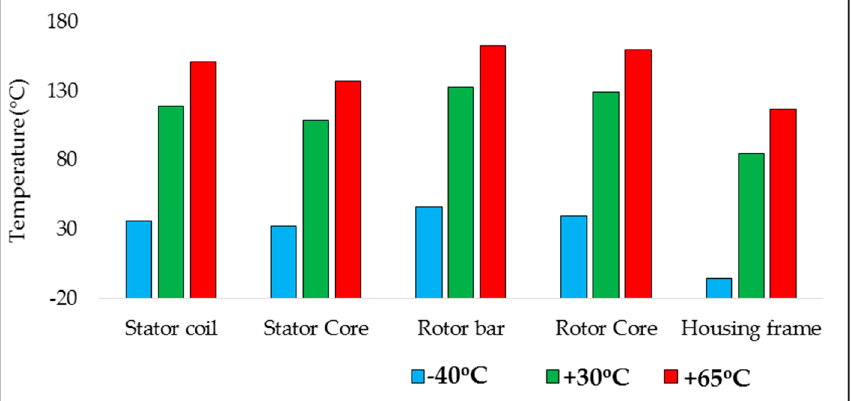
Figure 12. Temperature distribution of G2 for various ambient conditions ( − 40 °C, +30 °C, +65 °C).